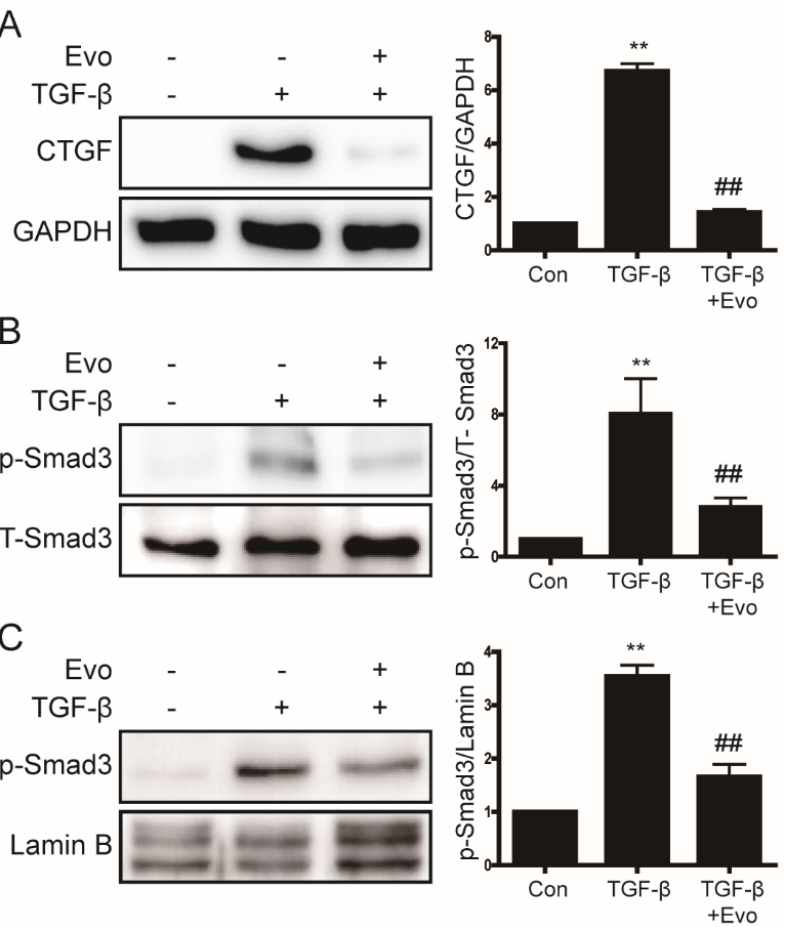
Figure 3. The inhibitory effect of evogliptin on TGF- β -induced CTGF levels and p-Smad3 expression. ( A , B ) Western blot analysis of the effects of evogliptin on TGF- β -induced CTGF levels and p-Smad3 expression in primary hepatocytes. Data in the bar graphs are represented as the mean ± SEM. ** p < 0.01 relative to the control, ## p < 0.01 relative to TGF- β . ( C ) Western blot analyses of nuclear extracts from primary hepatocytes showing the effect of evogliptin on TGF- β -induced p- Smad3 expression. ** p < 0.01 relative to the control, ## p < 0.01 relative to TGF- β .